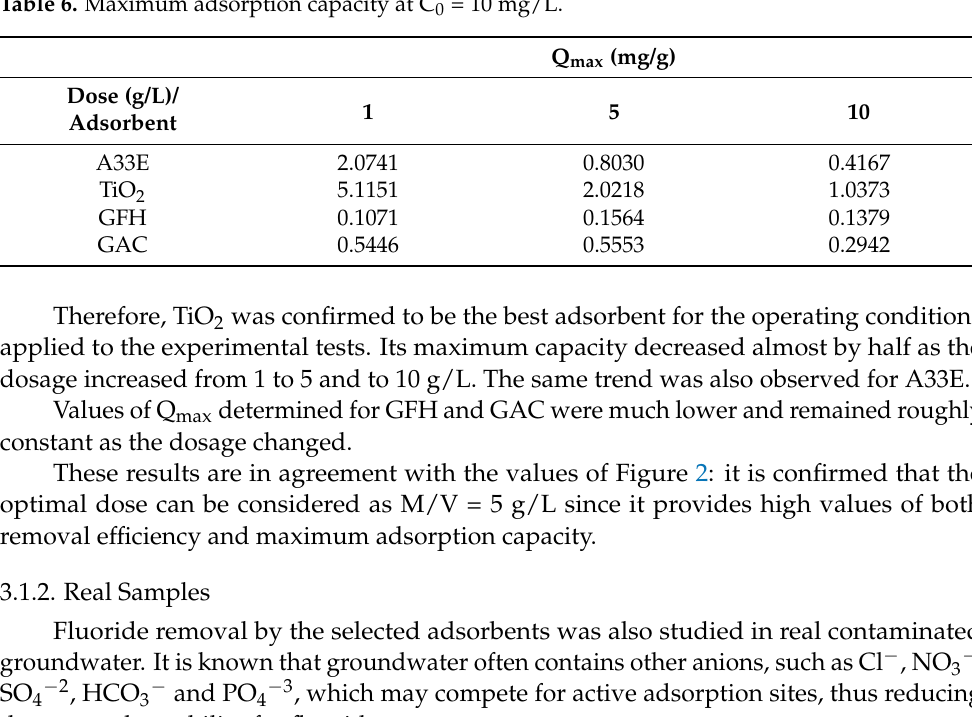
Table 6. Maximum adsorption capacity at C 0 = 10